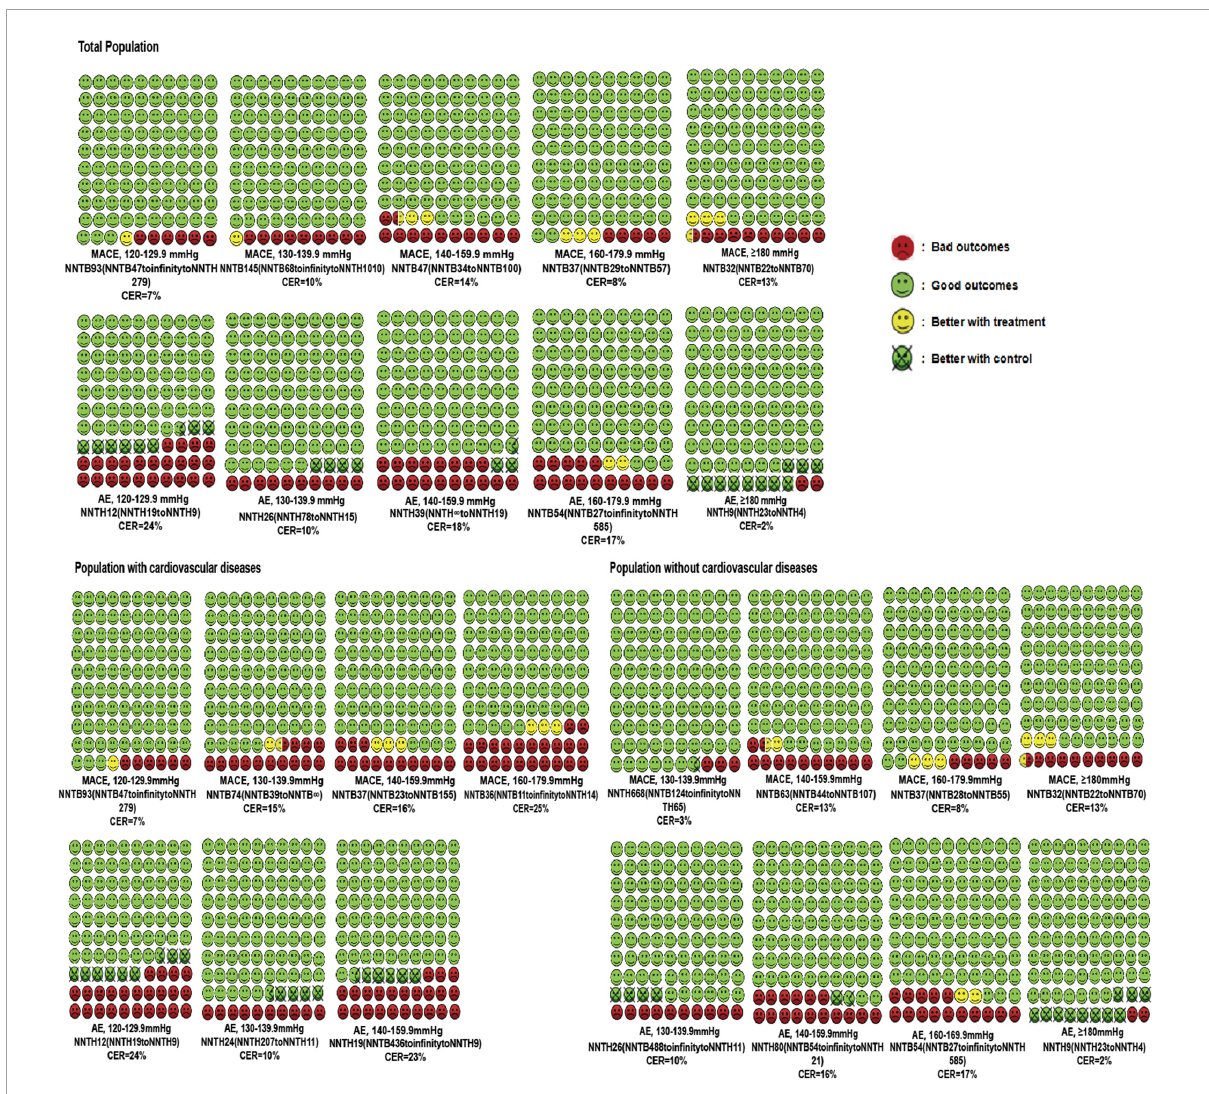
FIGURE2 Cates plot of the NNTs for primary outcomes across different SBP levels and cardiovascular diseases status. Each region is the value of NNT of MACEs or AEs in one SBP level and includes 100 faces corresponding to the patients treated with antihypertensive medication. Green faces mean patients not occurring MACEs or AEs with the treatment. Red faces indicate that patients presenting MACEs or AEs with the treatment. Yellow faces represent patients that would not have MACEs or AEs if they would be treated with the treatment. Crossed green faces present patients not fulfilled MACEs or AEs with a control group. Mean follow-up duration was 3.50